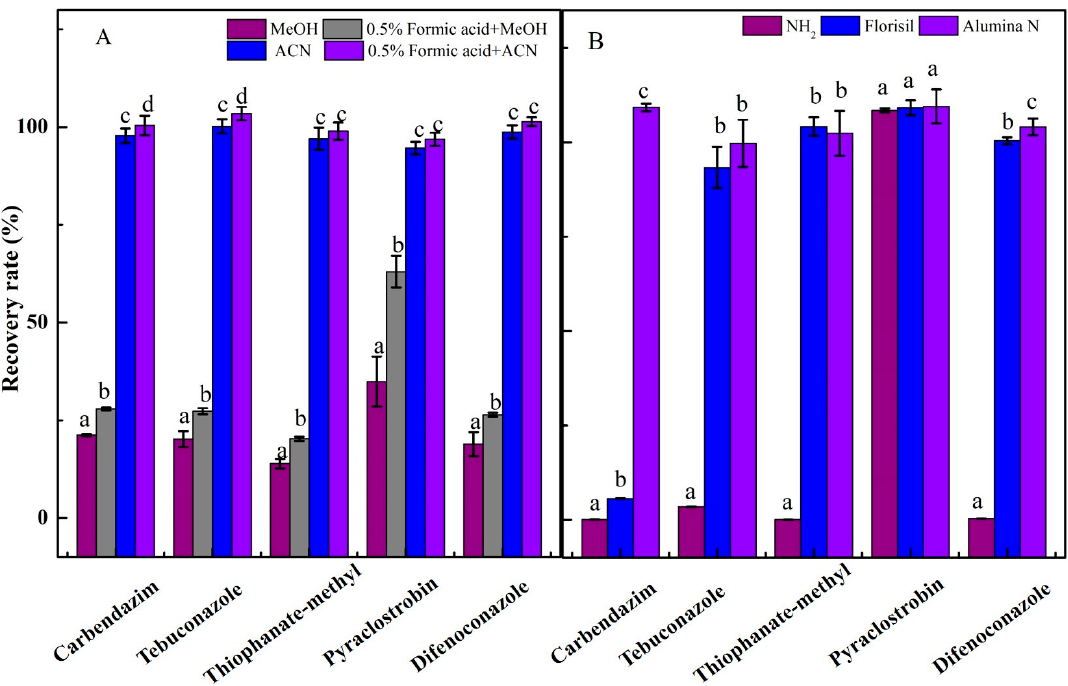
Figure 1. Effect of the different extraction solvents ( A ) and solid-phase extraction columns ( B ) on the extraction and purification of pear samples, respectively. The different lowercase letters are sig- nificantly different at p < 0.05.